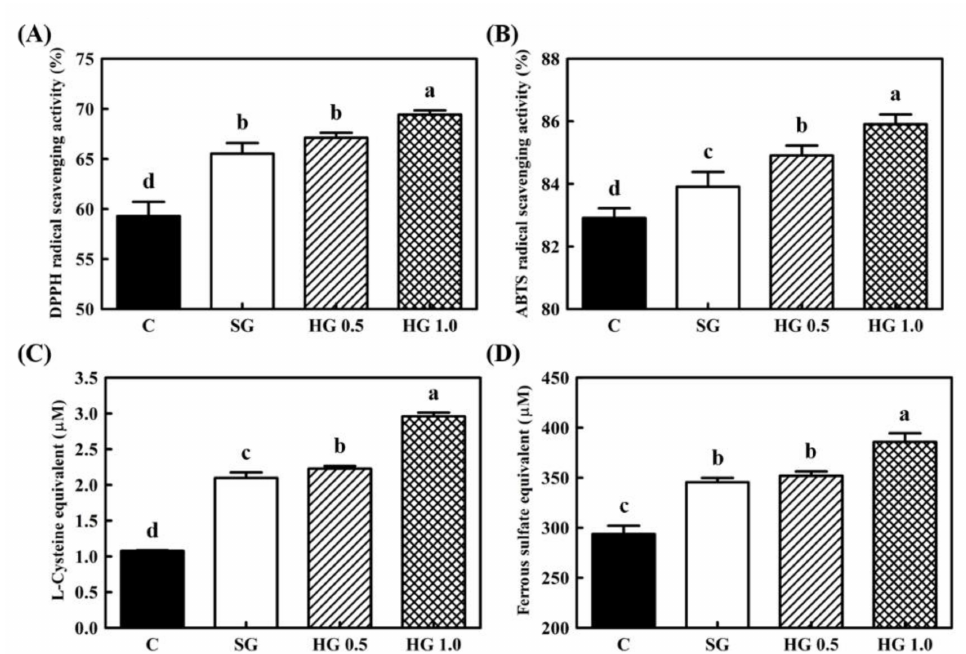
Figure 3. Antioxidant activity of ginseng extract-fortified yogurts. Four different antioxidant as- says were performed: ( A ) 2,2-Diphenyl-1-picryl-hydrazyl (DPPH) radical scavenging assay, ( B ) 2-azinobis-(3-ethylbenzothiazoline-6-sulfonic acid) diammonium salt (ABTS) radical scavenging assay, ( C ) reducing power assay, and ( D ) ferric reducing antioxidant power FRAP assay. ■ , C: Control yogurt without ginseng extract; □ , SG: 1.0% soil-cultured ginseng extract-fortified yogurt; ▨ , HG 0.5: 0.5% hydroponic ginseng extract-fortified yogurt; ▩ , HG 1.0: 1.0% hydroponic ginseng extract-fortified yogurt. The bars represent mean ± standard deviation of at least triple repetitive analysis. Different letters on the error bars indicate a significant difference between sample groups ( p < 0.05).